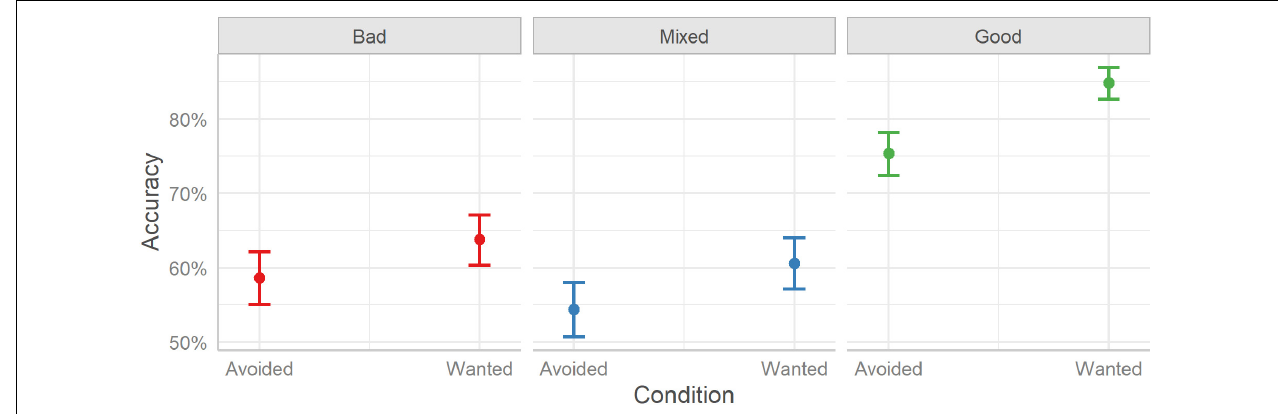
FIGURE 10 | User accuracy in correctly categorizing a profile as bad, mixed, or good between the two experimental conditions (Avoided and Wanted) split over the three Profile conditions (Bad, Mixed, and Good). Error bars indicate 95% credible intervals.